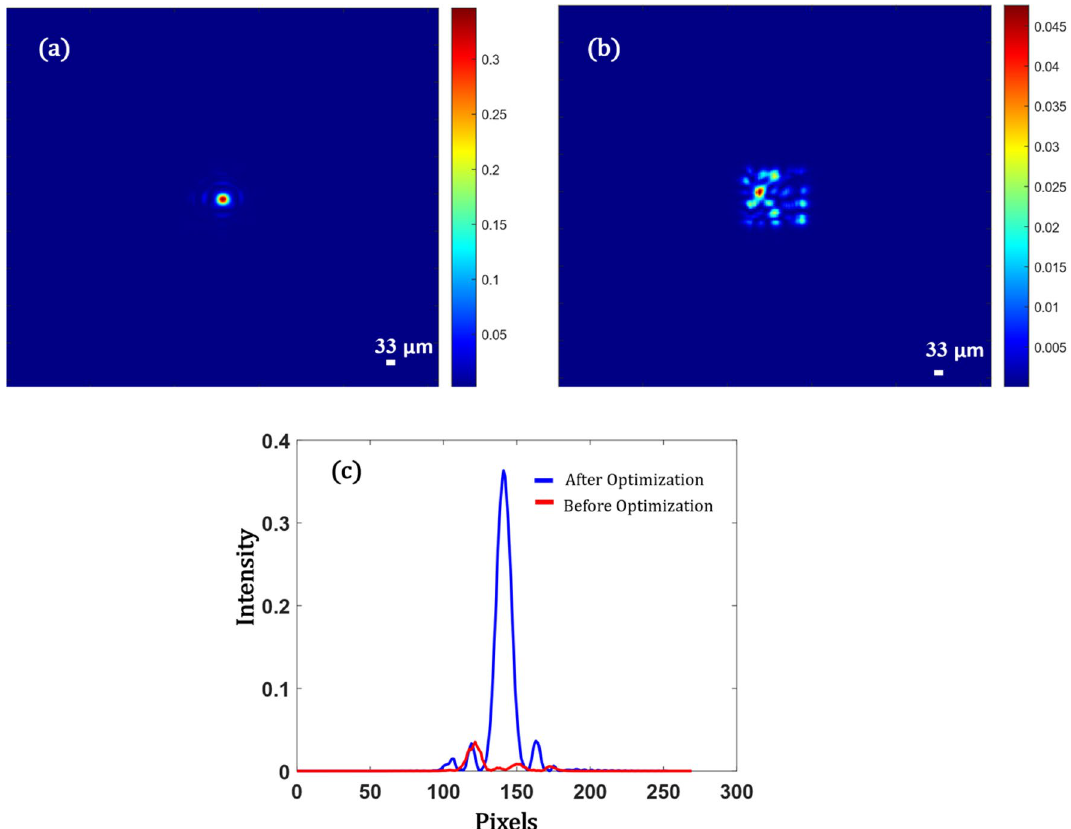
Figure 4. Simulation results showing, ( a ) Focus obtained on a different z plane, when the diffuser is illuminated with the optimized mask, ( b ) speckle pattern on the current z plane before optimization, ( c ) shows the profile view of the intensity pattern obtained in ( a ) and ( b